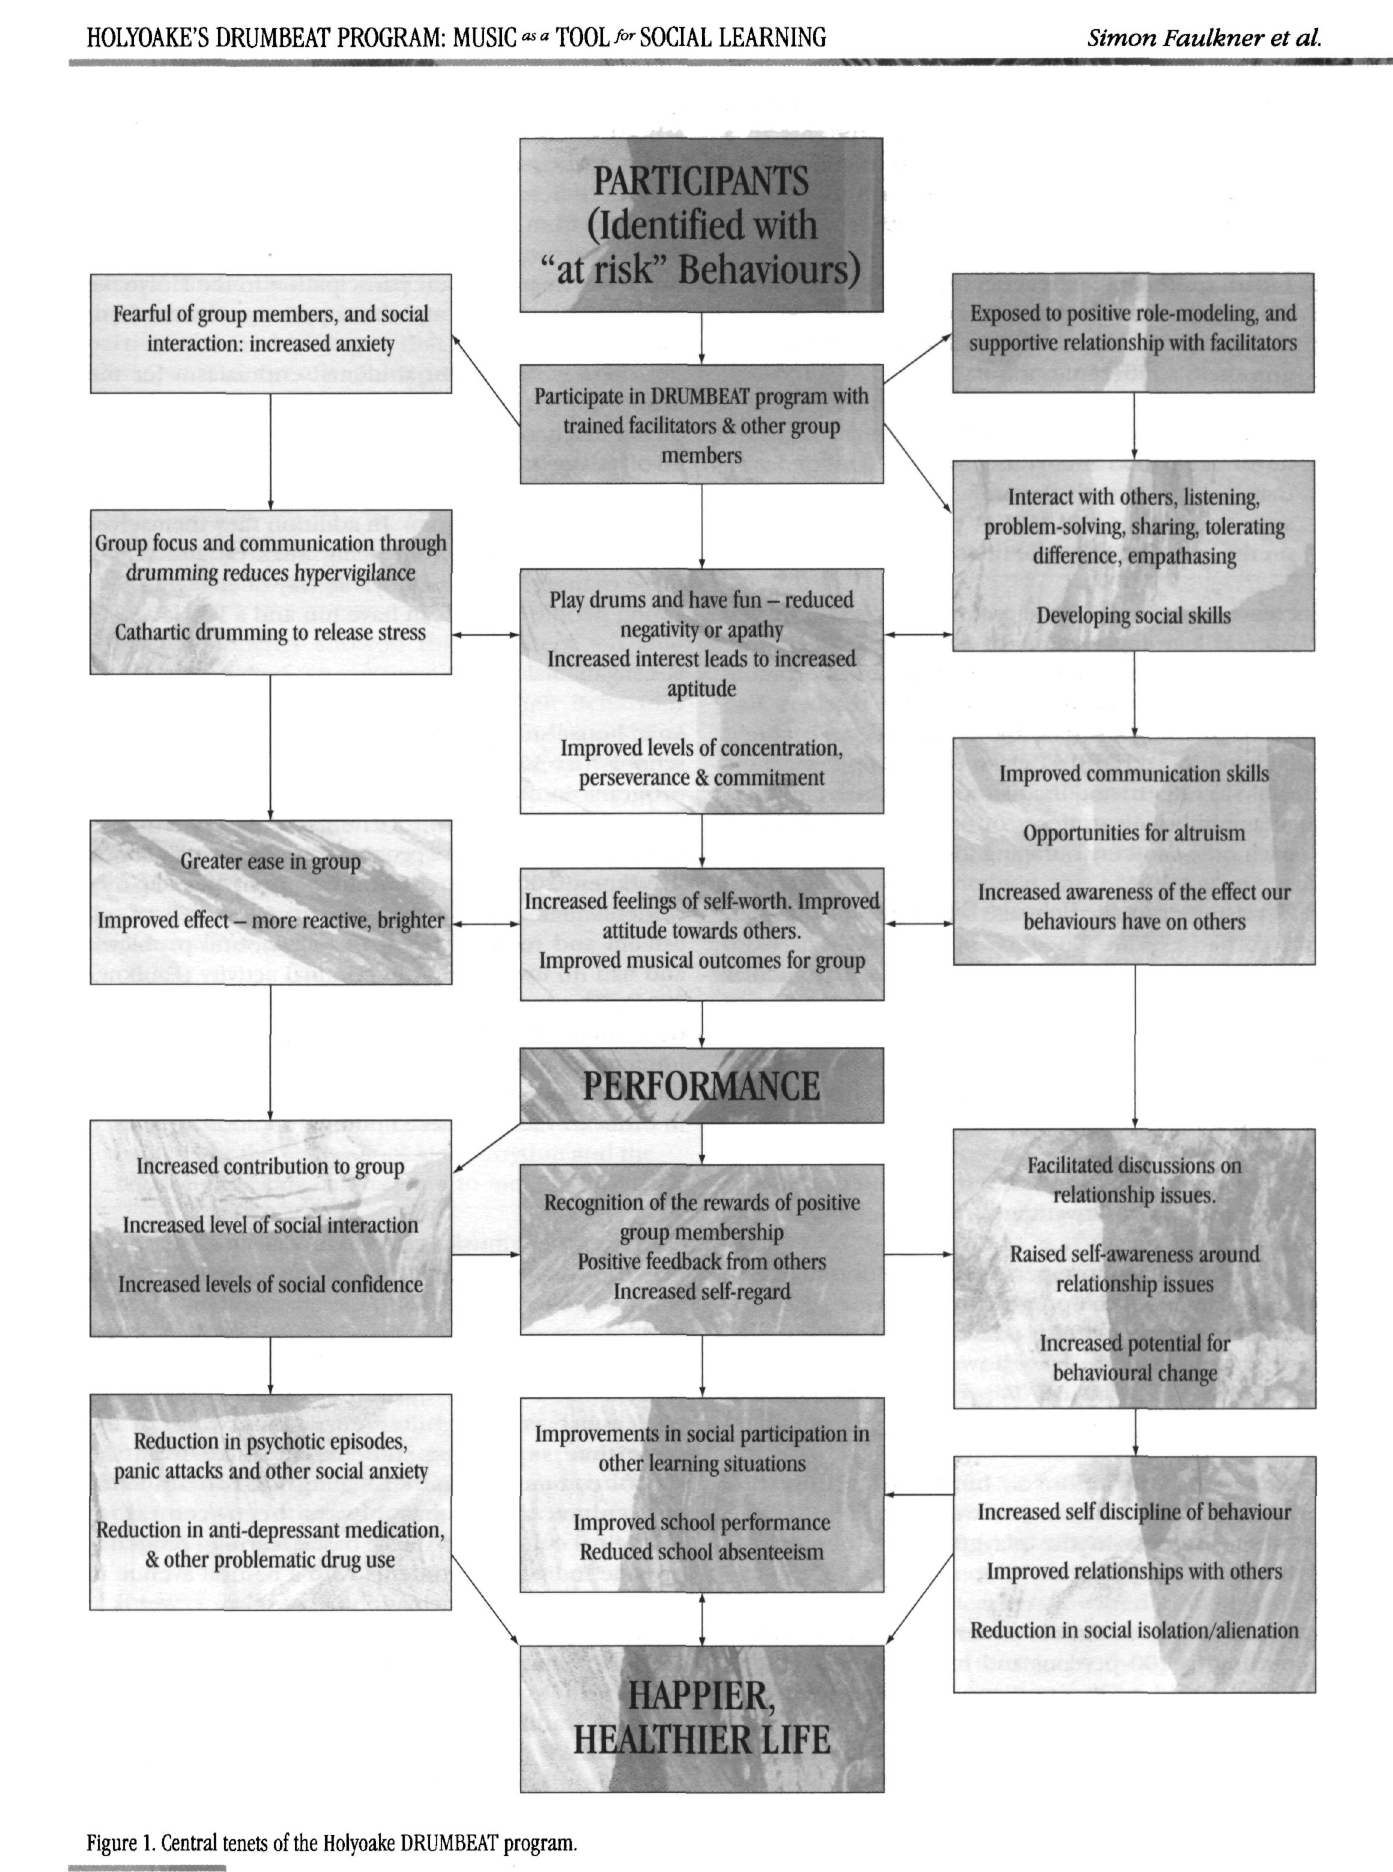
Figure 1. Central tenets of the Holyoake DRUMBEAT